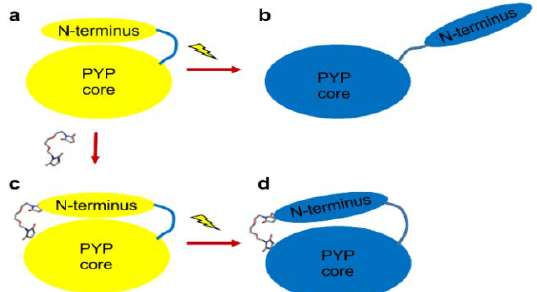
Figure 1. Schematic representation of the expected conformational change in the chemically modified photoactive yellow protein (PYP). The chemically modified protein includes the small-molecule linker (stick) covalently conjugated with the thiol groups (red-color) at the 7th and 91st residues. Wild-type PYP undergoes an N-terminal protrusion upon blue light excitation ( a → b ). In the chemically modified PYP (SML-PYP), the small-molecule linker plays a critical role in regulating the degree of structural change in the photoreaction of PYP, thereby limiting the N-terminus protrusion ( c → d ).